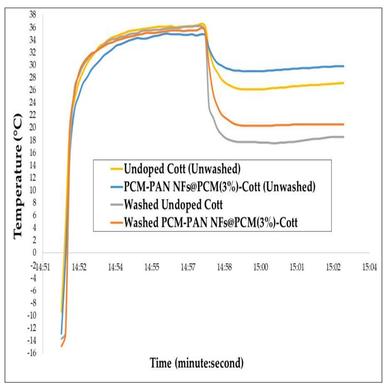
Thermoregulation function of undoped and core-shell structured cotton yarns after washing.